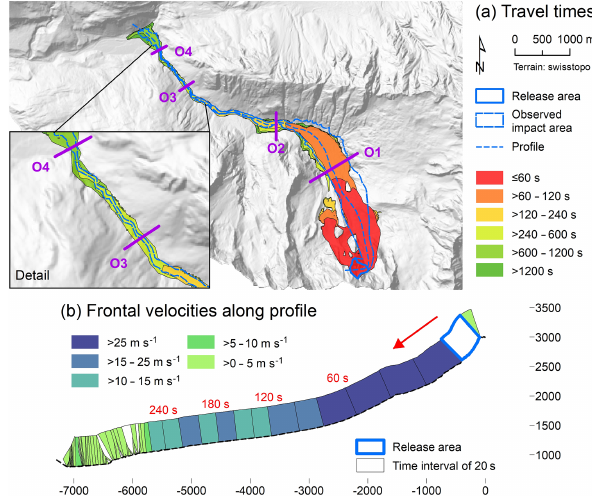
Figure 10. Spatio-temporal evolution and velocities of the event obtained for Scenario S1. (a) Travel times, starting from the re- lease of the initial rockslide–rockfall. (b) Frontal velocities along the flow path, shown in steps of 20s. Note that the height of the velocity graph does not scale with flow height. White areas indicate that there is no clear flow